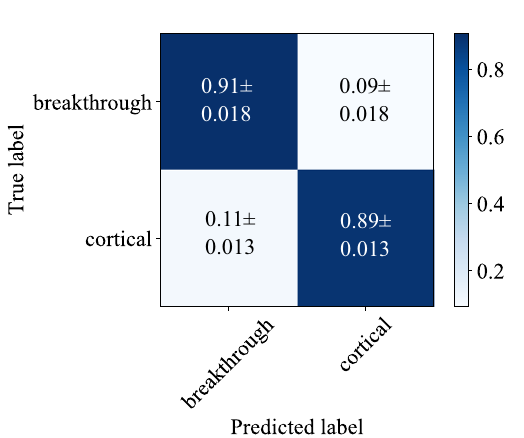
Figure 5. The normalized confusion matrix for a rectangular sliding window size of length L = 4410 samples which corresponds to a time frame of 100ms , recorded in the diaphysis